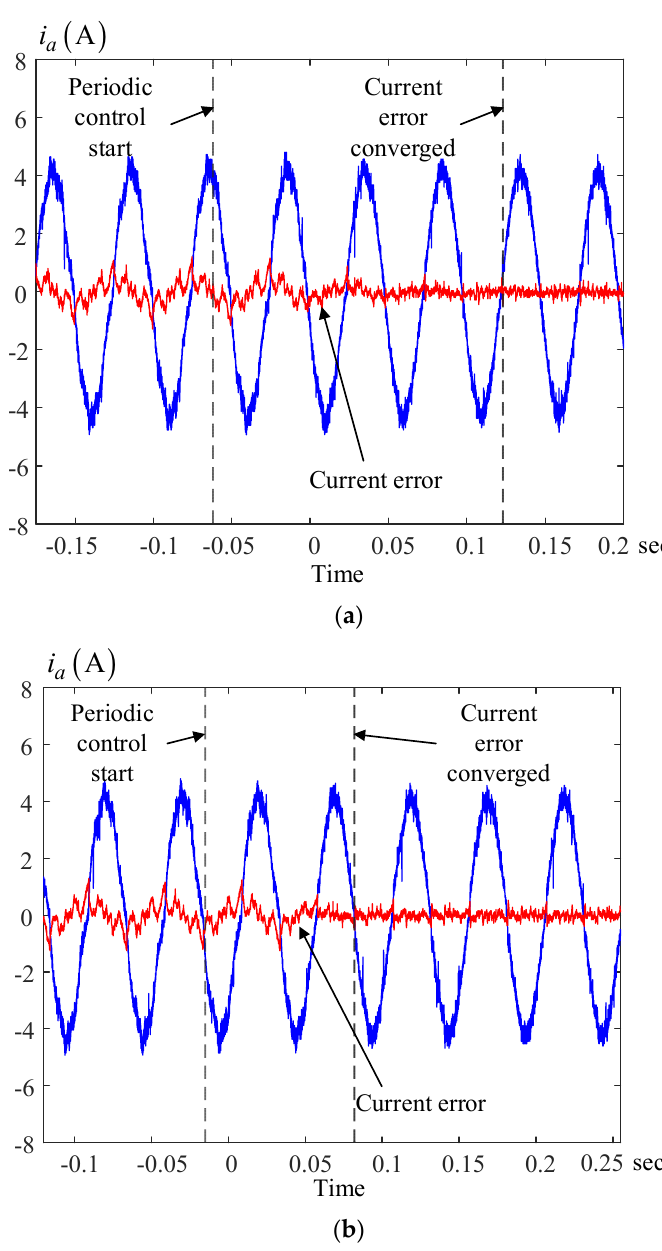
Figure 17. The measured currents and current errors: ( a ) CPC; ( b ) SHC.